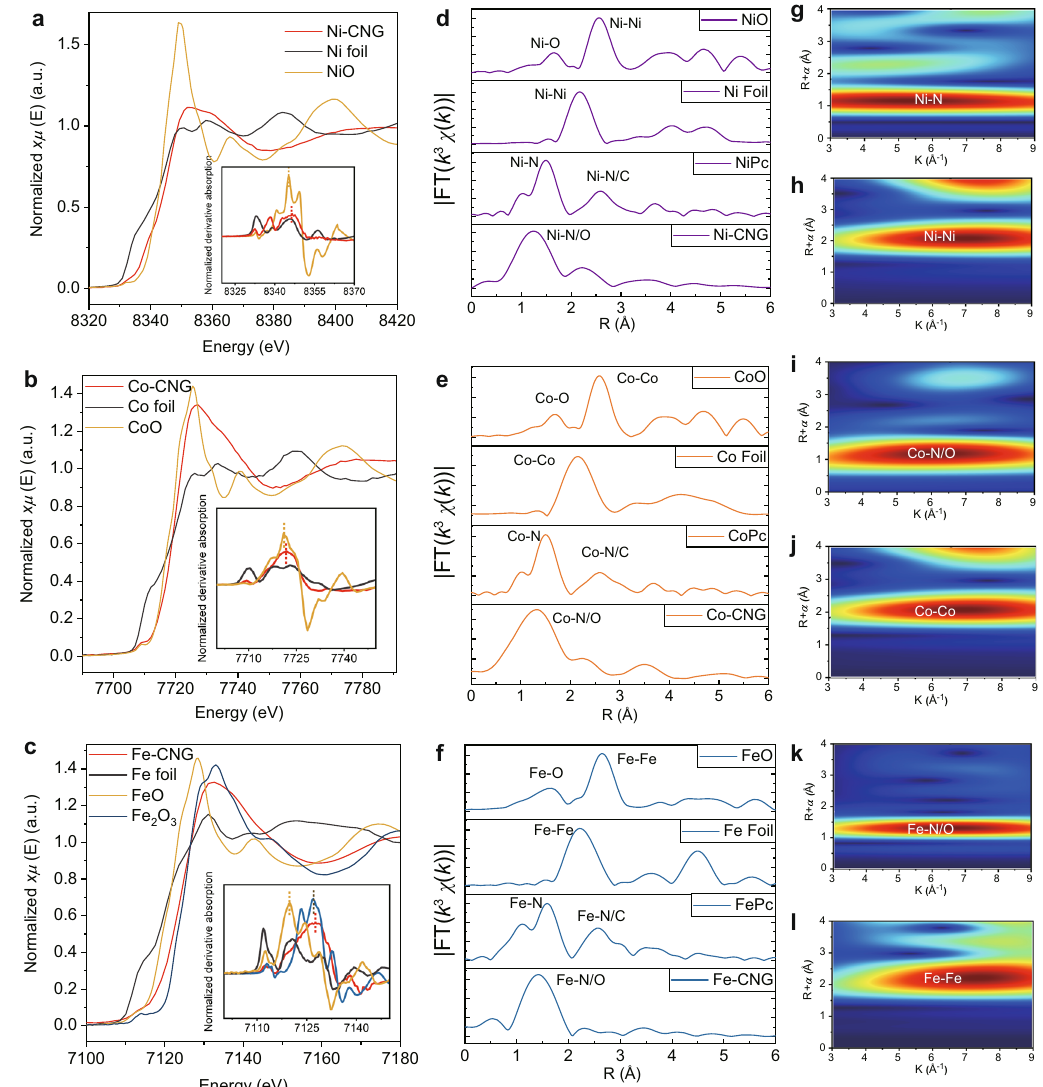
Fig. 2 Structural characterizations based on XAS. a – c K-edge XANES and d – f Fourier transform K-edge EXAFS spectra of Ni-CNG, Co-CNG, Fe-CNG, and their reference samples. g – l Wavelet transforms of the k 3 -weighted EXAFS signals of Ni-CNG, Co-CNG, and Fe-CNG and of their corresponding metal